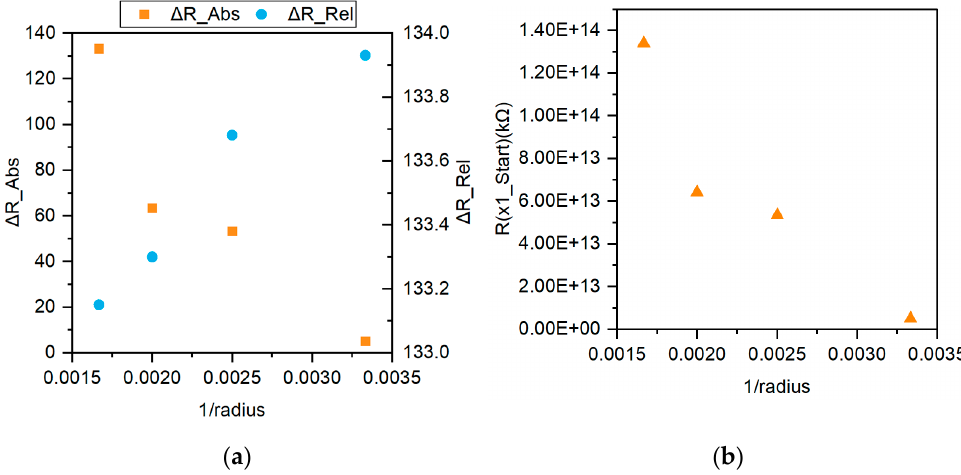
Figure 7. ( a ) Plots of the change in resistance using two different resistance references: Pre-strain (for the virgin sample) and pre-bending (for each test sequence); ( b ) Pre-bending resistance for the inverse bending radii of 600, 500, 400, and 300 mm.